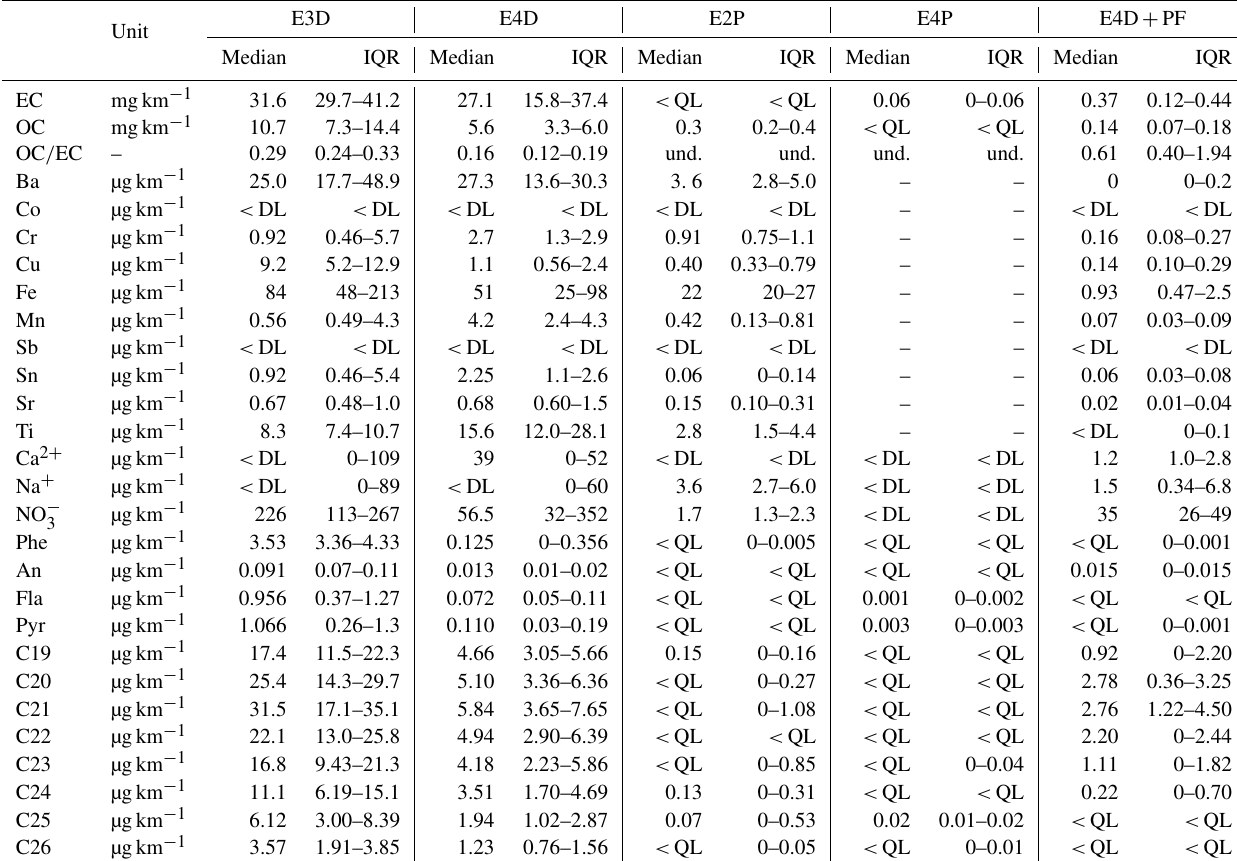
Table 4. Average emissions factors (median and IQR: interquartile range) determined by chassis dynamometer measurements for different types of passenger cars: Euro 3 diesel (E3D), Euro 4 diesel (E4D), Euro 2 petrol (E2P), Euro 4 petrol (E4P) and Euro 4 diesel equipped